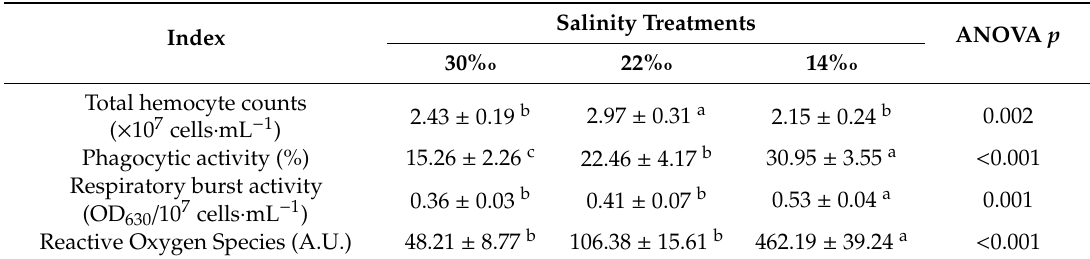
Table 1. E ff ects of a sudden drop in salinity on total hemocyte counts, phagocytic activity, respiratory burst activity, and reactive oxygen species (ROS) content of Anadara kagoshimensis . Salinity Index